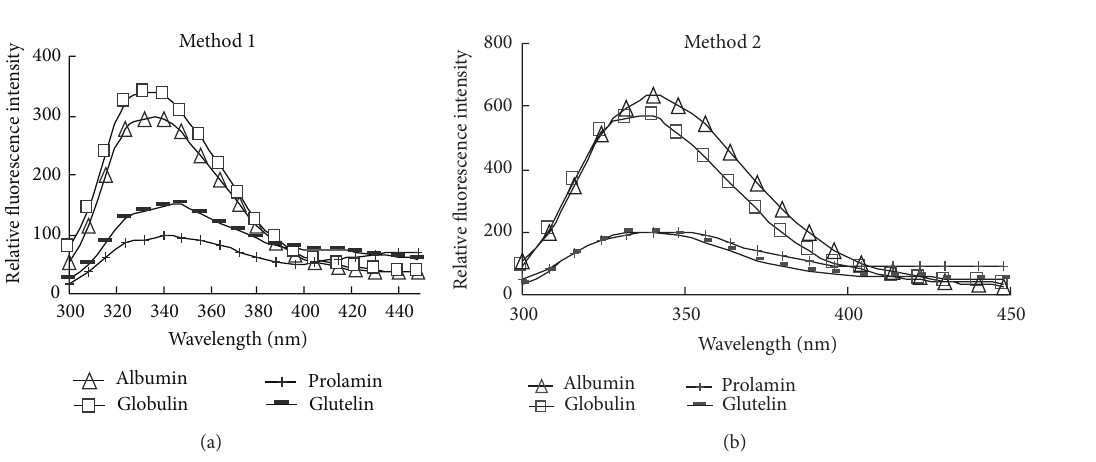
Figure 7: Intrinsic emission fluorescence spectra of FRBPs prepared by the two extraction